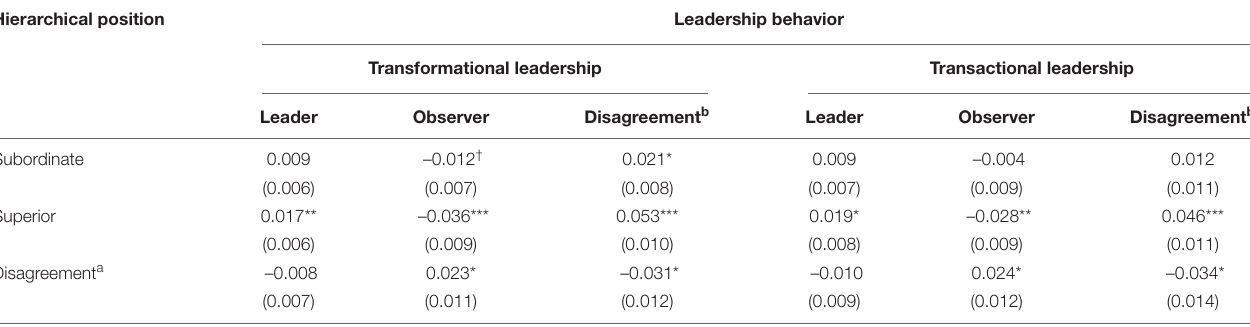
TABLE 5 | Simple main effects for leader-observer